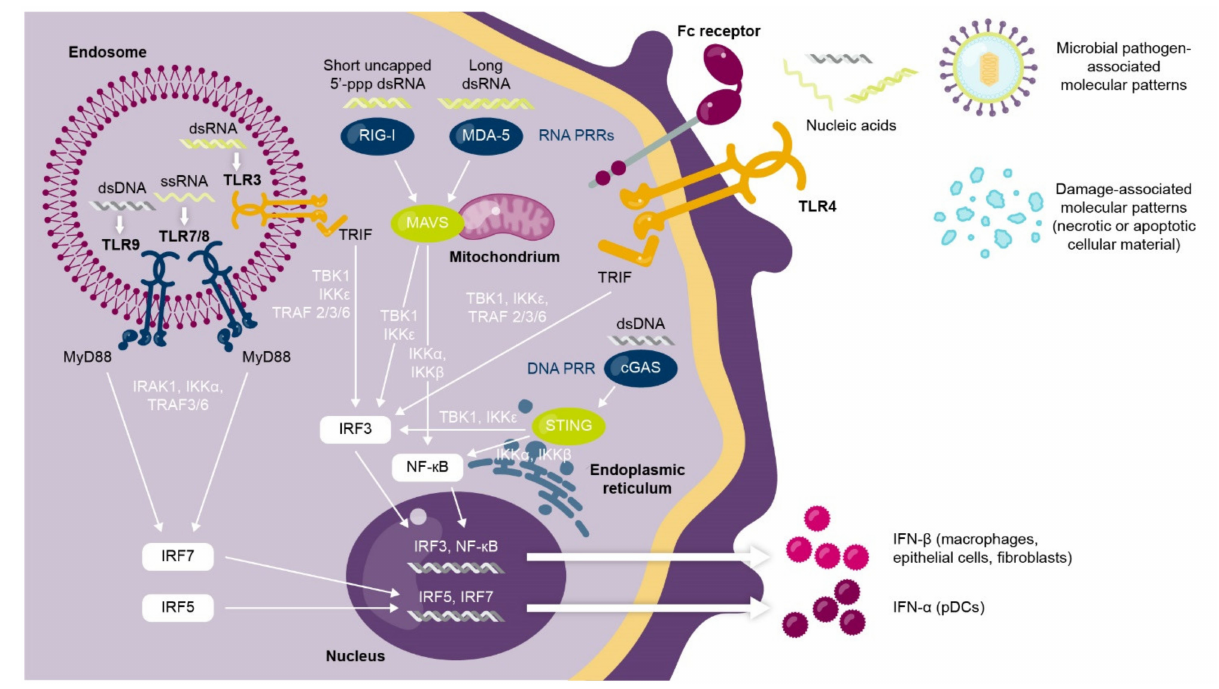
Figure 1. Activation of type I interferon response by viral nucleic acids and pattern recognition signaling pathways. Pattern recognition receptors located in the endosome (e.g., TLR3/7/8/9), the cell membrane (e.g., TLR4), or the cytoplasm (e.g., cGAS, RIG-I, MDA-5) detect viral nucleic acids to trigger a signaling pathway that results in type I interferon production from pDCs, macrophages, epithelial cells, and fibroblasts. cGAS, cGAMP synthase; ds, double-stranded; IFN, interferon; IKK, inhibitor of kappa B kinase; IRAK, interleukin 1 receptor-associated kinase; IRF, interferon regulatory factor; MAVS, mitochondrial antiviral-signaling protein; MDA-5, melanoma differentiation-associated protein 5; MyD88, myeloid-differentiation primary response protein 88; NF, nuclear factor; pDC, plasmacytoid dendritic cell; PRR, pattern recognition receptor; RIG-1, retinoic acid inducible gene-I; ss, single-stranded; STING, stimulator of interferon genes; TLR, Toll-like receptor; TBK1, TRAF family associated NF- κ B activator (TANK)-binding kinase-1; TRAF, tumor necrosis factor receptor-associated factor; TRIF, TIR domain-containing adaptor inducing interferon- β